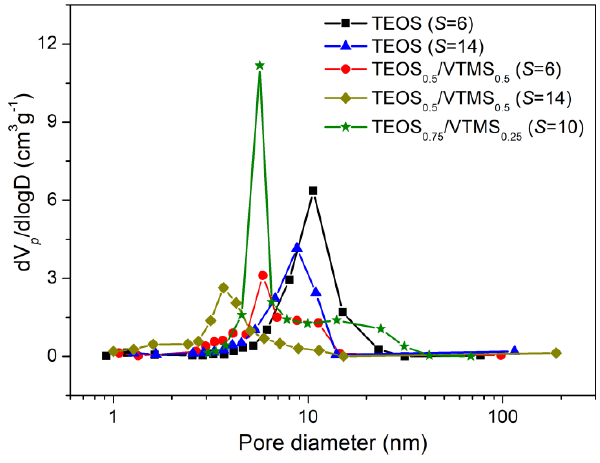
Figure 5. Pore size distribution in the region of mesopores and small macropores for different aerogel systems.